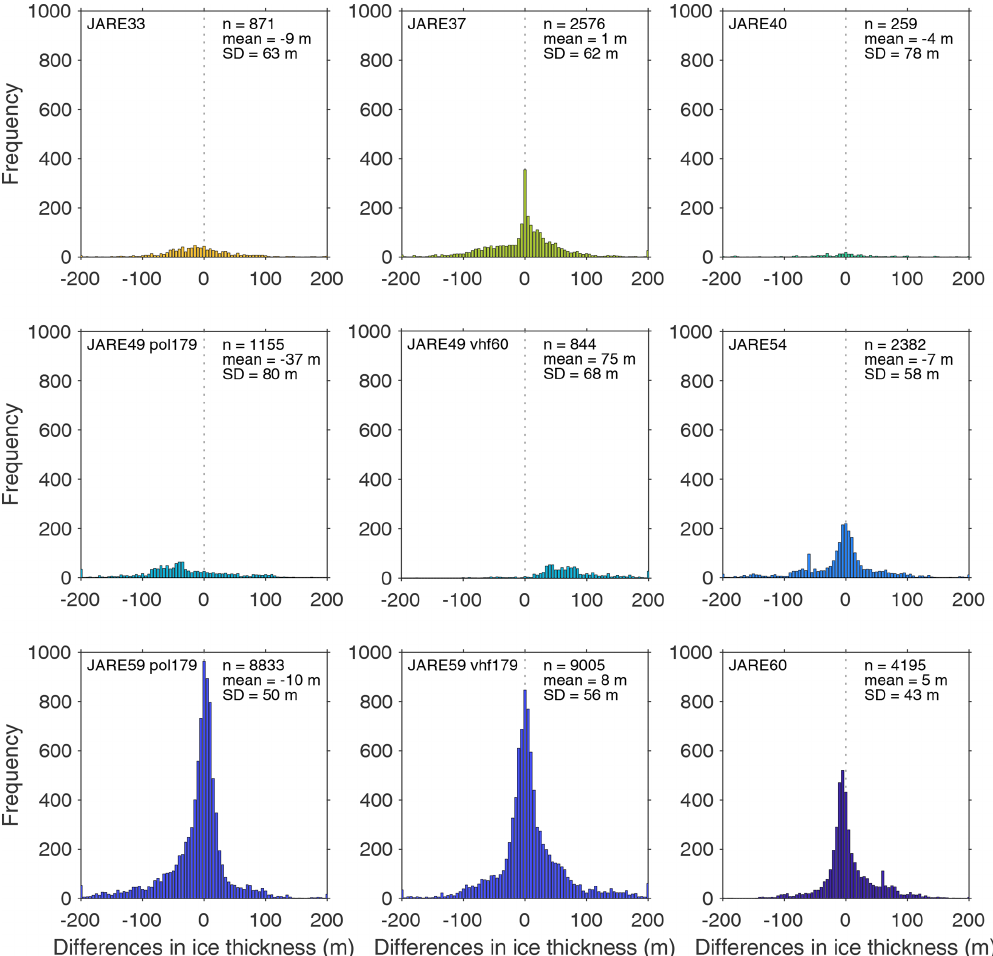
Figure 4. Histogram of the ice thickness difference between the point data from each radar survey and the JARE59 and JARE60 radar surveys. Note that the histograms and statistical values do not account for the geometrical effects of the finite beam pattern of radar antennae on survey data